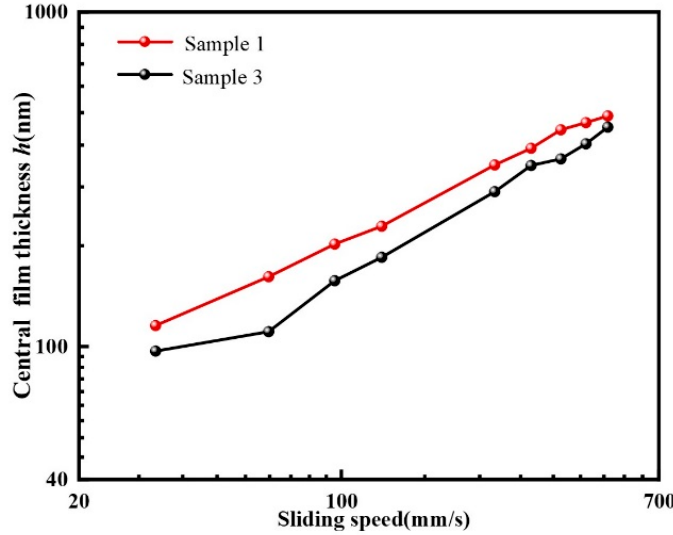
Figure 6. Comparison of central film thickness of sample 1 and sample 3 (load = 16.7 N).